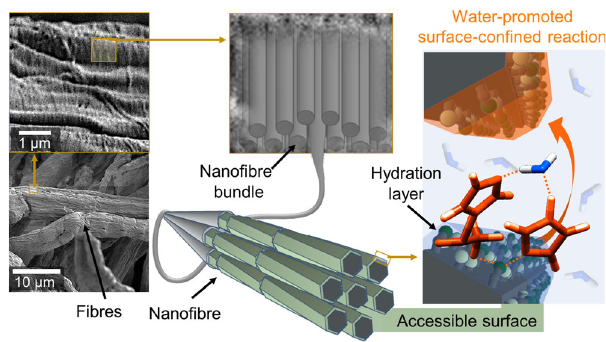
Fig. 1 Hydration layers in nanoporous polymers as reaction media. Cellulose, as representative example of a hierarchically structured biopolymer, is composed of individual nano fi bres (i.e. elementary fi brils), organised into micro-scaled fi bres with nanopores and con fi ned spaces that originate from their inter fi brillar assembly. Only the surface of these fi bers is chemically accessible (accessible OH-groups are shown as light and dark green beads) and, under ambient conditions, is covered with a hydration layer comprising surface-con fi ned water. This water is explored as nanomedium to promote chemical